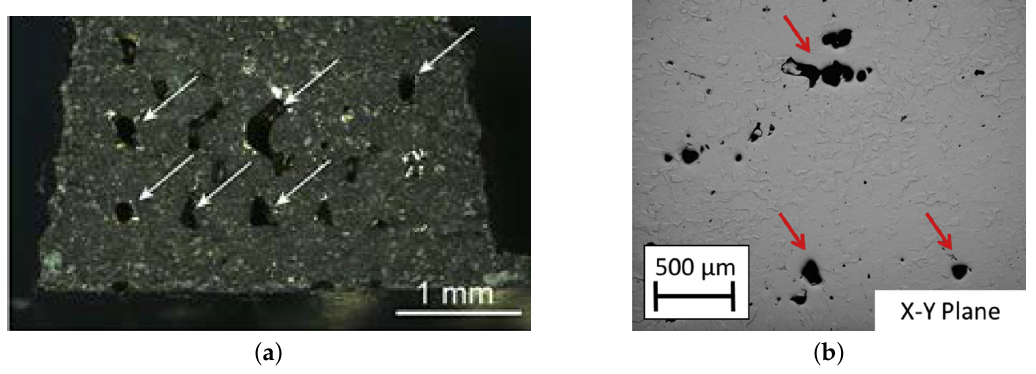
Figure 18. Images of additively manufactured NdFeB bonded magnets and iron-silicon. Here, black features indicated by the arrows in the images represent pores. ( a ) Cross-section of bonded NdFeB magnets fabricated with material extrusion [59]; ( b ) Optical micrograph of selective laser melted iron-silicon